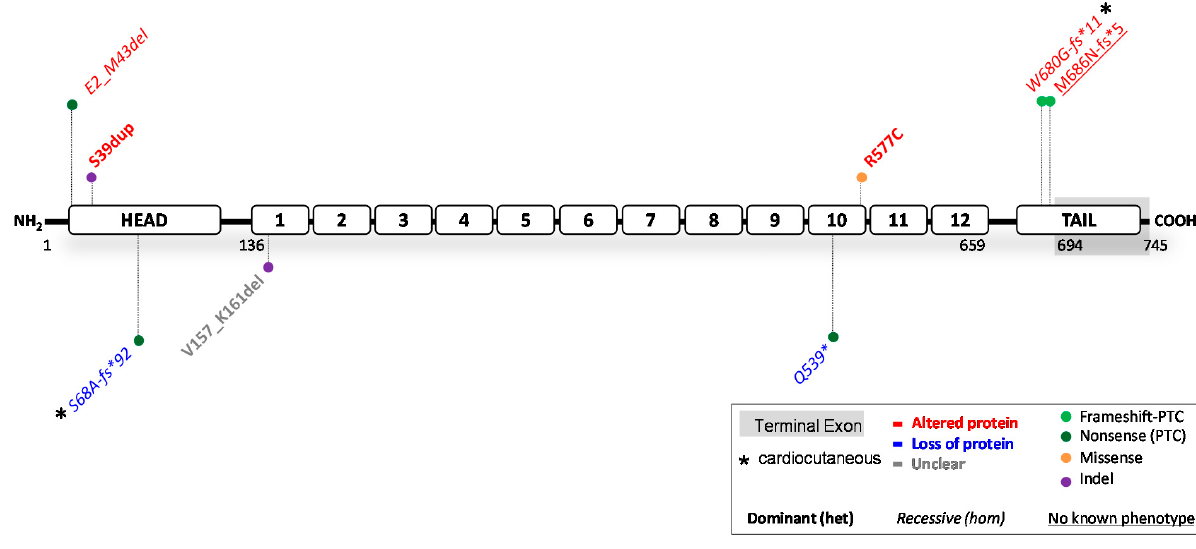
Figure 3. Location of functionally investigated JUP variants.